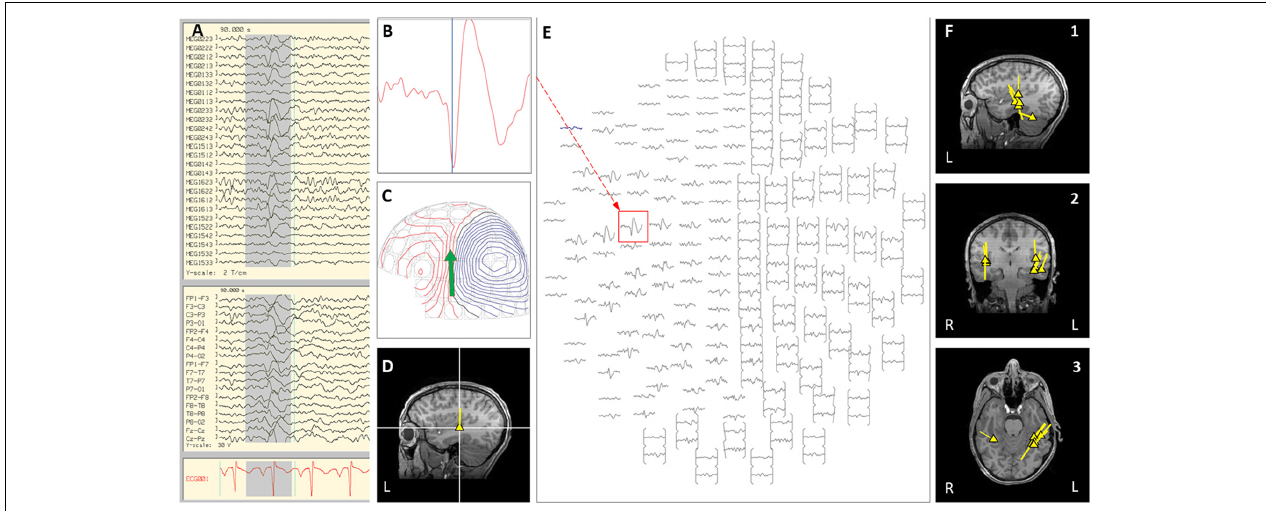
FIGURE 5 | Case 24 (A–E) provide an example of an individual simultaneous MEG–EEG discharge in the left temporal sensor area. (B) Selected MEG channel and time instance of the magnetic field distribution (C) in sensor space with the projected source estimate (green arrow). The sagittal MRI slices (D) indicates the origin (triangle) and source orientation (tail) of a single discharge at the left temporo-parietal junction. The MEG channel plot (E) of the selected time interval as shown in (A) shows the region of interest and the planar gradiometer channel (red squared box) with the earliest peak time. The summary pictures (F1–F3) show left greater than right posterior temporal distribution (see Figure 5 ) (yellow